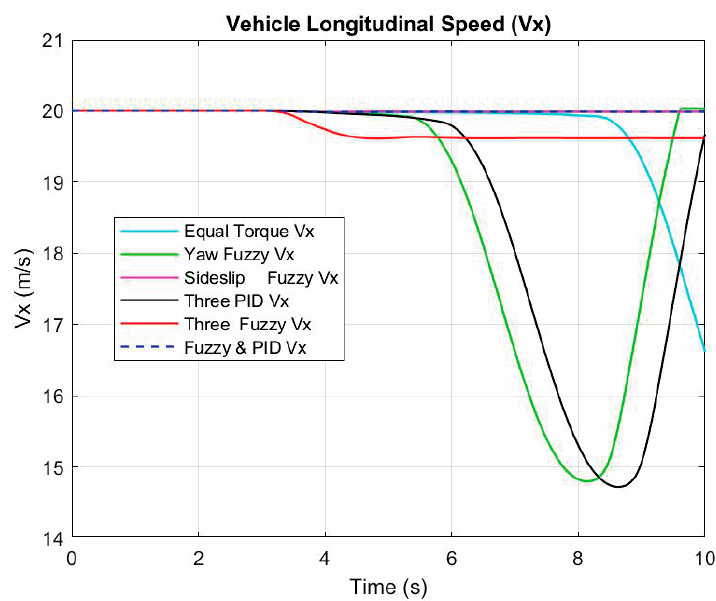
Figure 9. Longitudinal speed response of the six control methods.